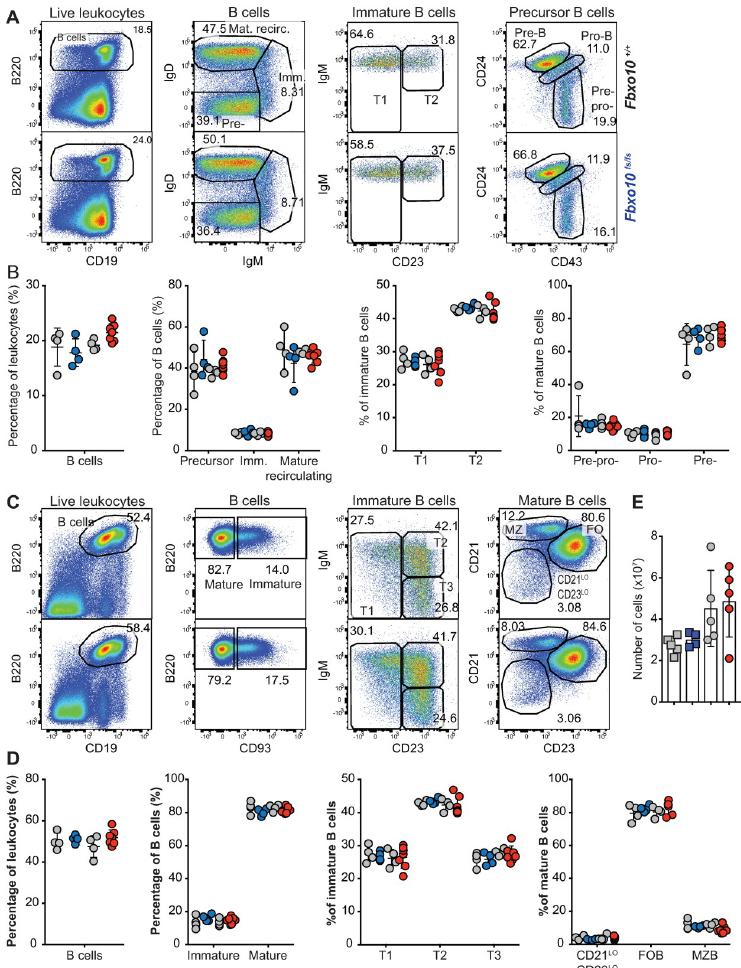
Fig 2. Fbxo10 frameshift or missense mutation do not discernably affect B cell subsets in the bone marrow or spleen. (A) Representative flow cytometric gating strategy to delineate B cell developmental subsets in the bone marrow. Numbers denote cells in the gate as percentage of parent population. (B) Frequency of indicated B cell subsets in the bone marrow in Fbxo10 fs/fs and Fbxo10 +/+ littermate control mice (blue and left set of grey circles, respectively) and in Fbxo10 E54K/$54K and Fbxo10 +/+ littermate control mice (red and right-hand grey circles, respectively). (C) Representative flow cytometric gating strategy to delineate splenic B cell subsets. (D) B cell subsets in the spleen of Fbxo10 +/+ , Fbxo10 fs/fs and Fbxo10 E54K/E54K mice. (E) Spleen cellularity in Fbxo10 fs/fs and littermate control mice (blue and grey circles, respectively) and in Fbxo10 E54K/$54K and Fbxo10 +/+ littermate control mice (red and grey circles, respectively). (B, D, E) Each dot represents data from an individual animal. Data are representative of n = 2 experiments on mice 40–50 weeks old, and similar results observed in n = 2 experiments on mice 10–20 weeks old. Statistical analysis: t-test corrected for multiple comparisons using the Holm-Sidak method yielded no evidence for significant differences between mutants and wild-type controls with p < 0.05.